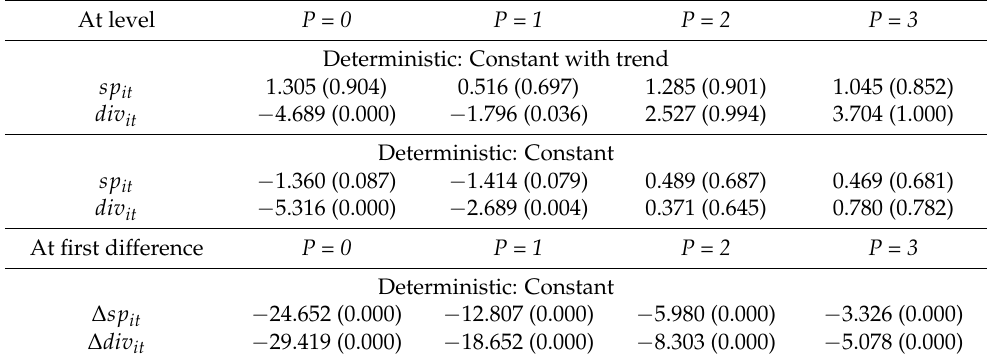
Table 4. Pesaran (2007) second-generation CIPS test.